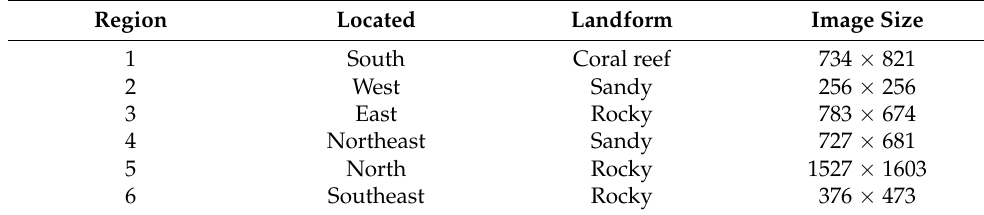
Table 2. Information of the selected